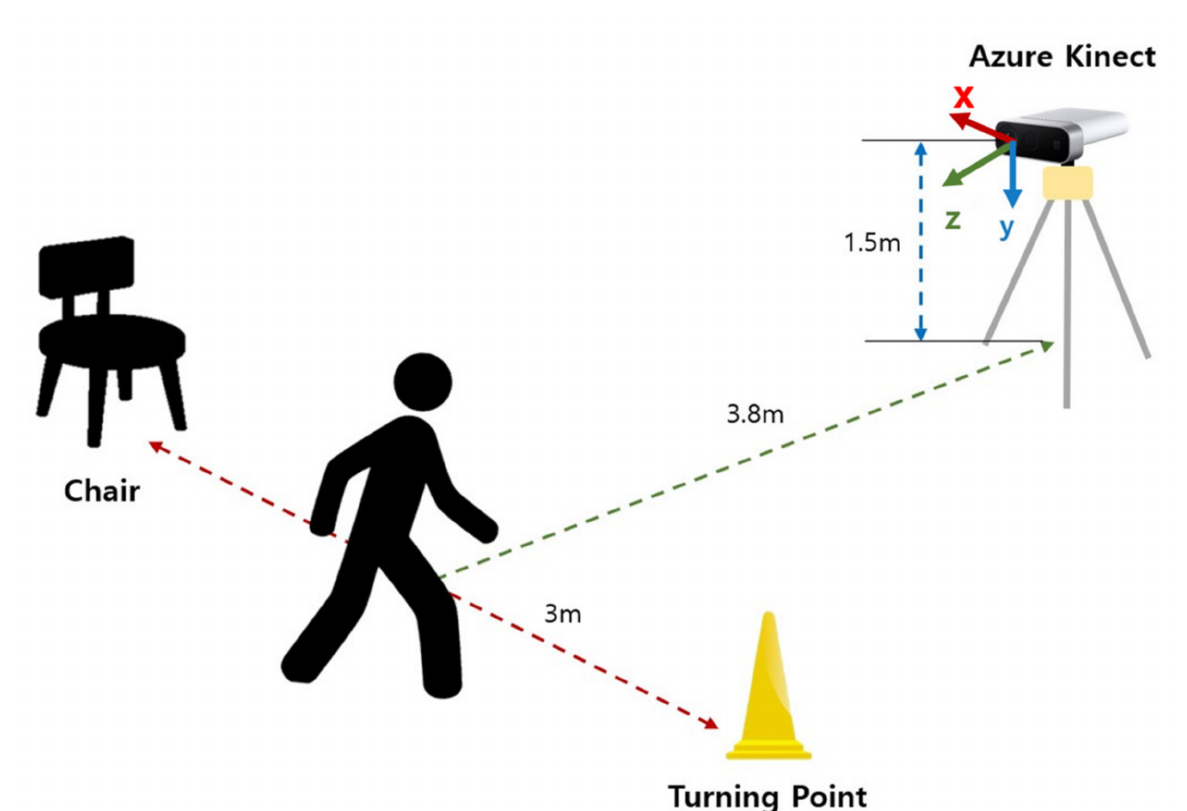
Figure 1. System configuration for the study. The participants performed a 3 m TUG test. A cone was placed at 3 m straight from a standard chair, and Azure Kinect was installed perpendicular to the walking direction at the height of 1.5